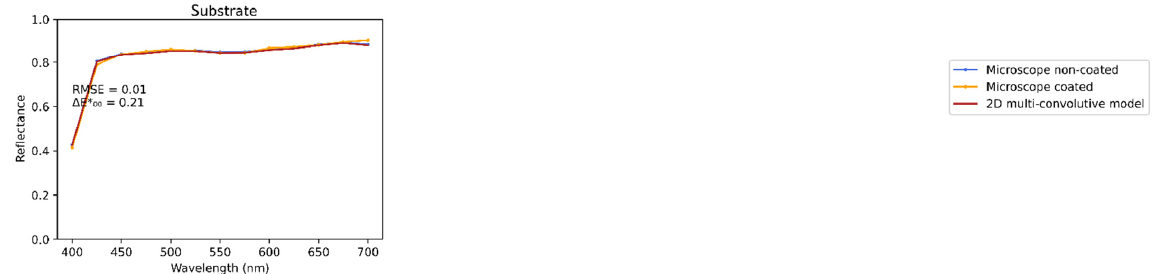
Figure 7. Spectra of the magenta line halftones, averaged over the spatial dimension. Patch 1 to 8 have a period of respectively: 0.168, 0.252, 0.337, 0.421, 0.505, 0.839, 1.263, and 2.104 mm. A specular component of 0.04 is added to all spectra.